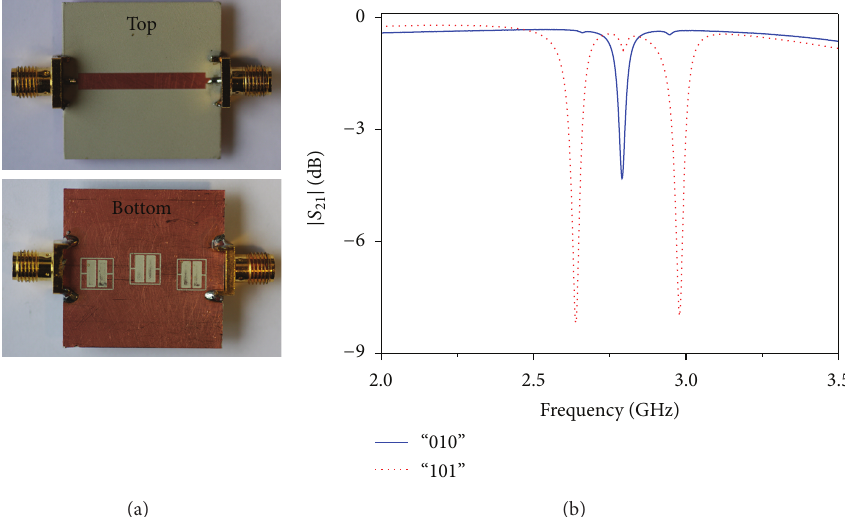
Figure 11: Photograph of a 3-bit RF bar code (codified as “101”) (a) and measured frequency response (b). For completeness, the measurement for the code “010” is also shown. The substrate is Rogers RO3010 with thickness ℎ = 1.27 mm, dielectric constant 𝜀 𝑟 = 11.2 , and loss tangent tan 𝛿 = 0.0023 . The line width is designed to minimize the insertion loss with the presence of the MLCs symmetrically etched, that is, = 5.2 mm, 𝑤 = 𝑠 = 0.2 mm, 𝑙 = 1.9 mm, 𝑙 (2.6 GHz ) = 6.32 mm, 𝑙 (2.8 GHz ) = 6 mm, 𝑊 = 3.13 mm. The MLC dimensions are 𝑤 1 2 1 2 2 (3 GHz ) = 5.72 mm, and 𝑙 = 6 mm. The distance between adjacent resonators is set to that for which interresonator coupling can be 𝑙 2 3 neglected, that is, 3 mm. The lateral displacement to set the logic state “1” is